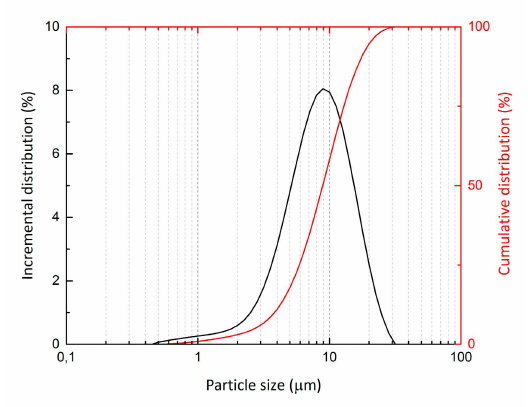
Figure 1. Particle size distribution of graphite powder obtained via laser